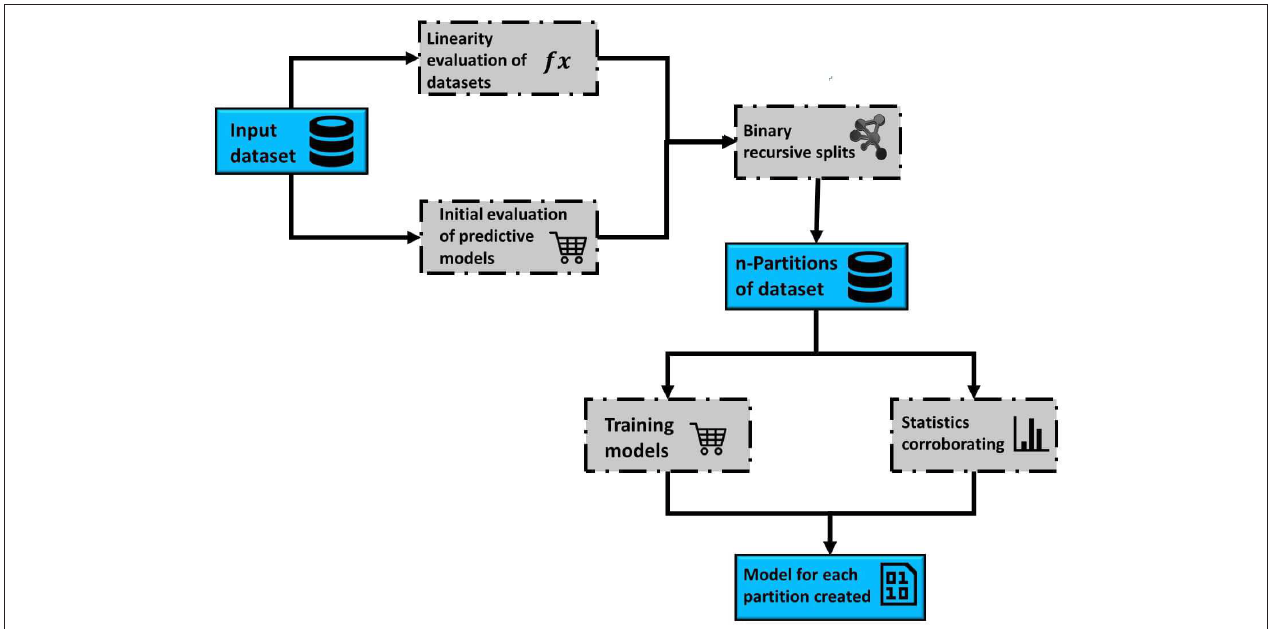
FIGURE 1 | Representative scheme of the workflow associated with the methodology proposed to develop predictive models for highly non-linear datasets, based on the use of the RV-Clustering